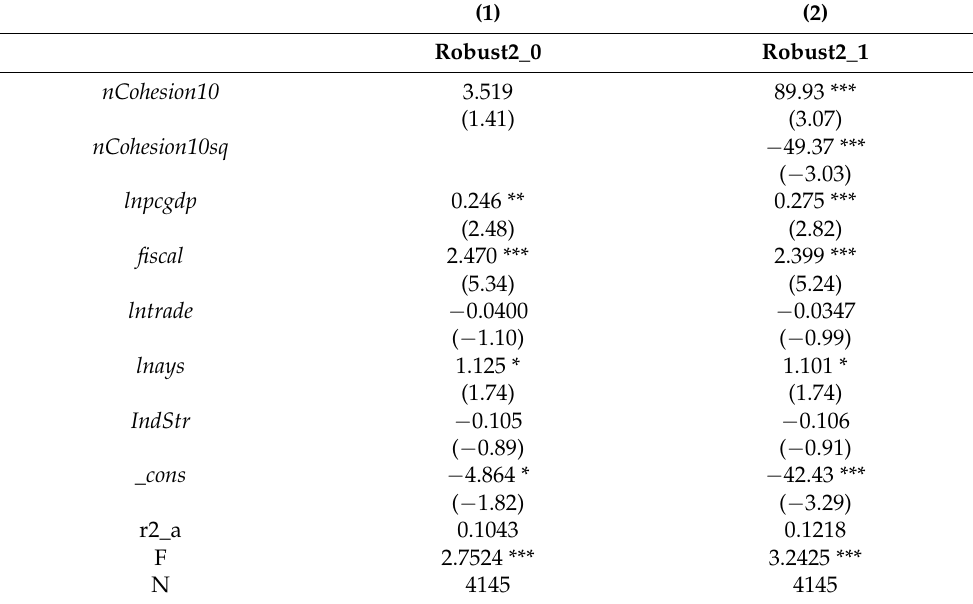
Table 8. Robustness tests: impact of city shape on location